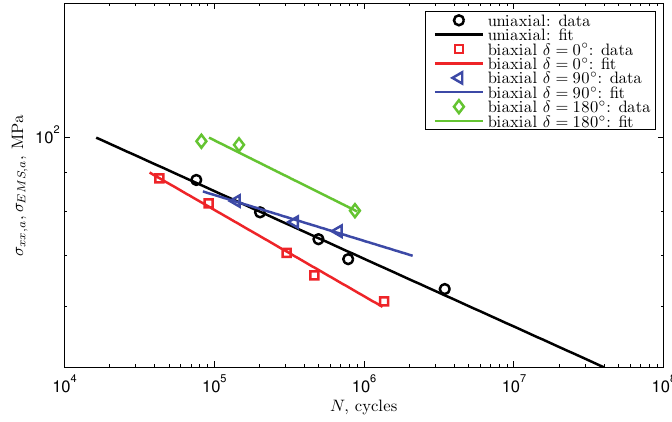
Figure 2: SN curves uniaxial and biaxial data presented by Cláudio et al.